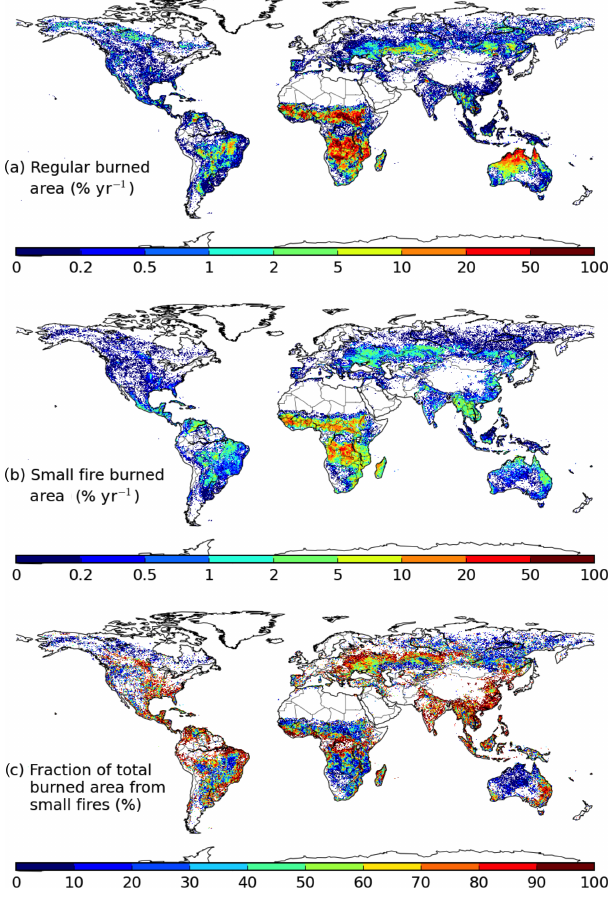
Figure 1. Average burned area over 2003–2016 from (a) MODIS surface reflectance imagery (MCD64A1) and (b) small fire burned area. Panel (c) shows the small fire percentage of total burned